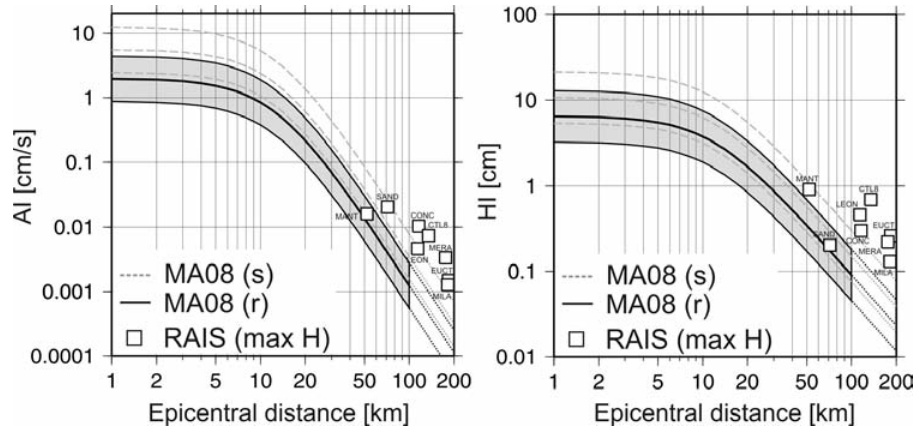
Figure 5. Comparisons between the Arias (left, AI) and Housner (right, HI) intensities calculated from the July 17, 2011, recordings (considering the maximum horizontal component) and the related relationships calibrated for northern Italy by Massa et al. [2008] (MA08). Solid black lines, dashed gray lines, models (median ±1 v ) calibrated for hard rock and soft soil, respectively. For both empirical models, the explanatory variable for distance was valid up to 100 km, and was extrapolated up to 200 km (black and gray dots). Labels for the RAIS stations are